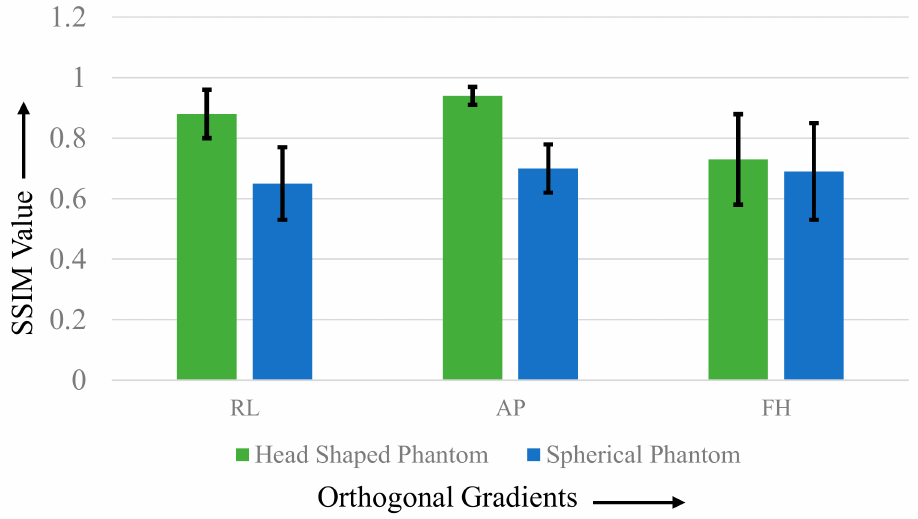
Figure 8. The structural similarity (SSIM) variation between the subjects’ map and the head-shaped phantom map (green) and between the subjects’ map and the spherical phantom map (blue). The error bar shows the standard deviation of the SSIM variation over the trials. Note: SSIM is a unitless quantity, in the range